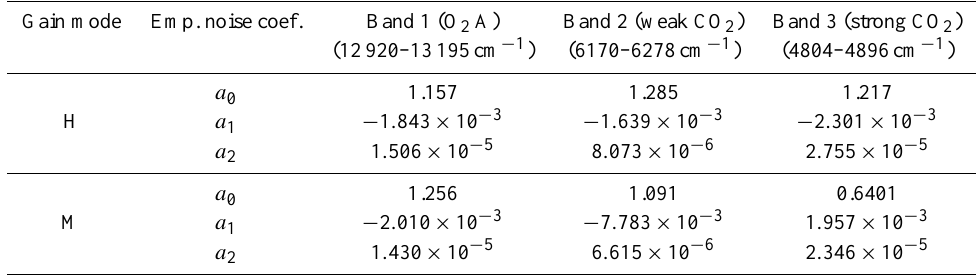
Table 1. Coefficients for empirical noise for GOSAT high (H) and medium (M) gain observations over land. Gain